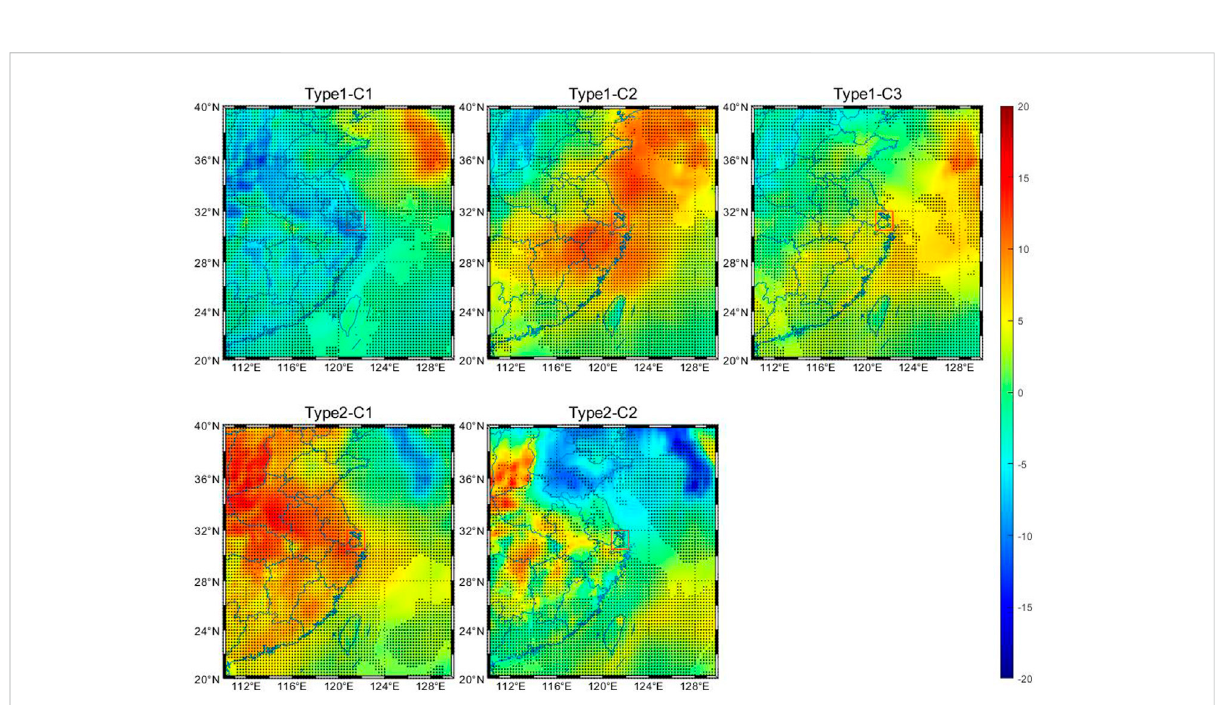
FIGURE 8 Anomaliesofrelativehumidityin5clusters.ThesolidbluelineinthebackgroundindicatestheprovincialboundariesofChina.Differentsubtitles represent differentclusters.The blackdots indicate thatthegridsare abovethe99%con fi dencelevel ( p < 0.01). The solidredbox marks thelocation of Shanghai. Unit: